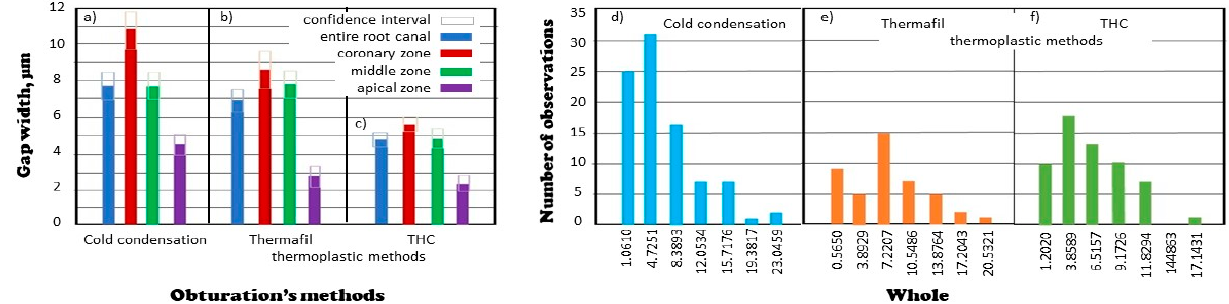
Figure 17. Generalization of the measurement results: ( a – c ) statistical analysis of the measurement results of the gap between the sealant and dentin of root canals filled with material based on gutta-percha; ( d – f ) histograms of the width of the gaps in the entire root canal after filling with the following methods: ( a , d ) cold; ( b , c , e , f ) thermoplastic condensation method with the use of: ( b , e ) Thermafil; ( c , f ) THC.